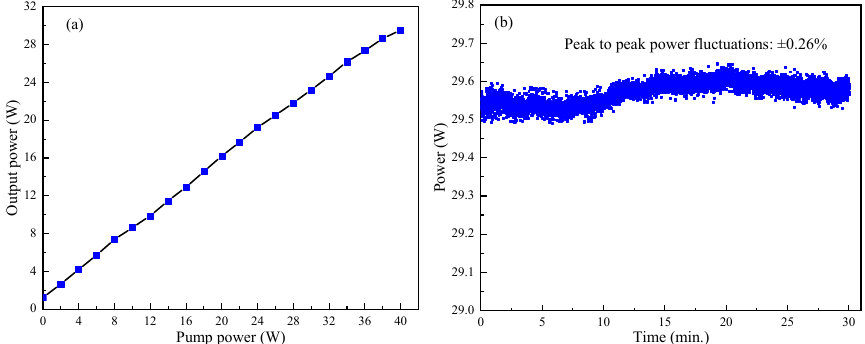
Figure 3. ( a ) Output power of the second-stage amplifier versus pump power; ( b ) Power stability within 30